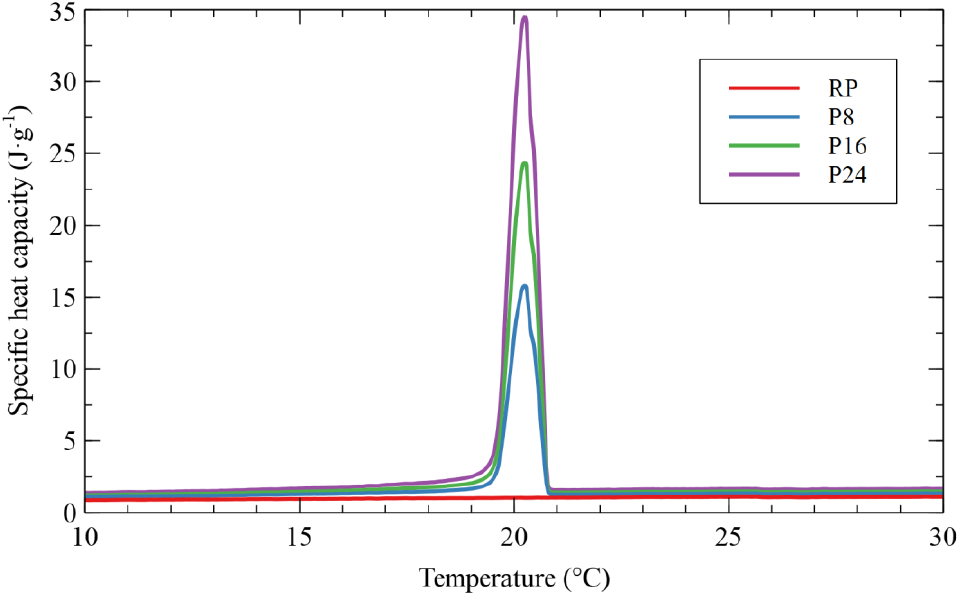
Figure 3. Temperature-dependent specific heat capacity of studied FSPCM plasters during cooling.